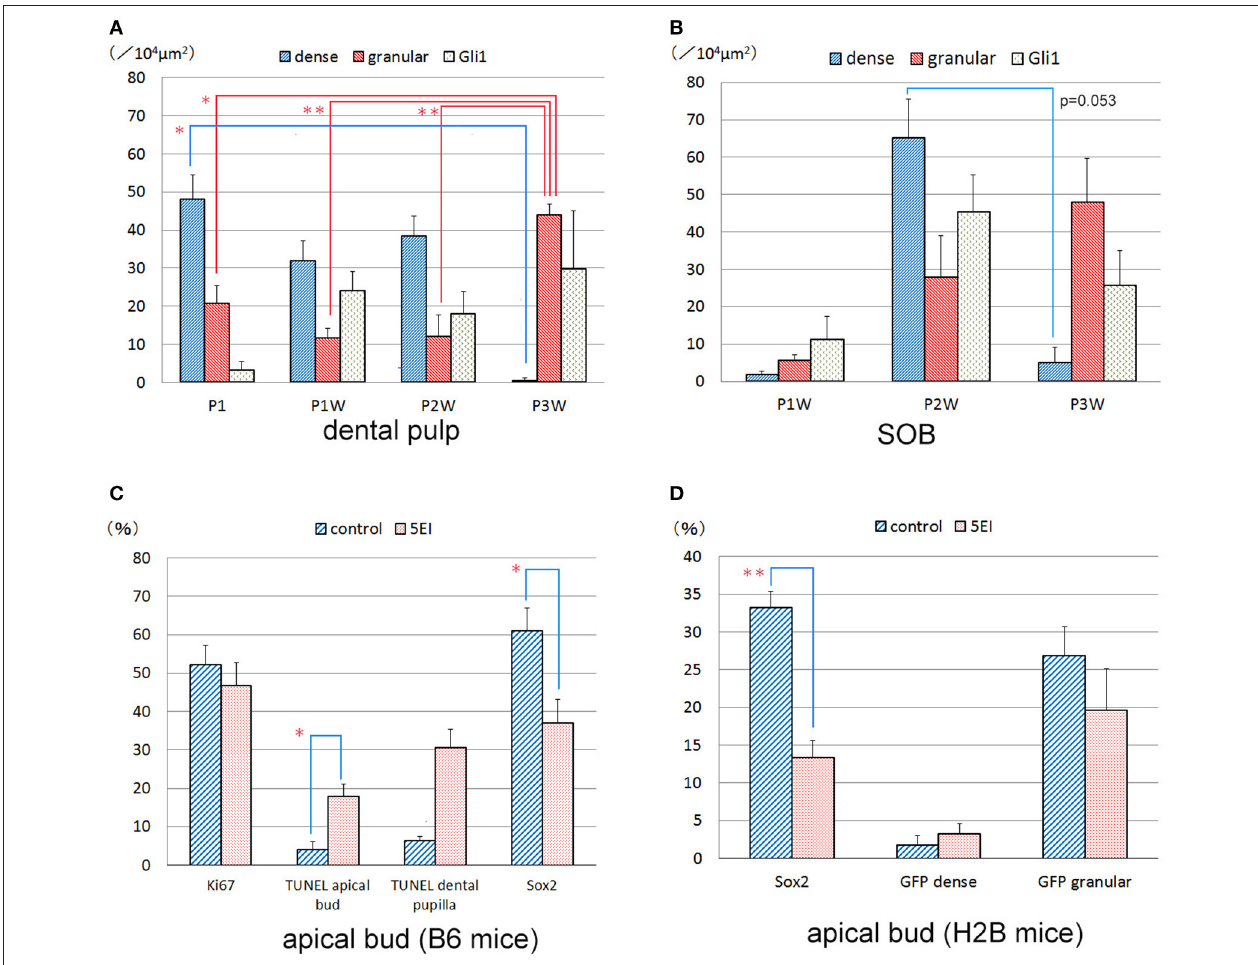
FIGURE 6 | Quantitative analysis of dense GFP + , granular GFP + , Gli1 + , Ki67 + , TUNEL + , and Sox2 + cells in the dental pulp (A) and subodontoblastic layer (SOB) (B) of the developing molars (A,B) and the incisor explants (C,D) . * P < 0.05, ** P <